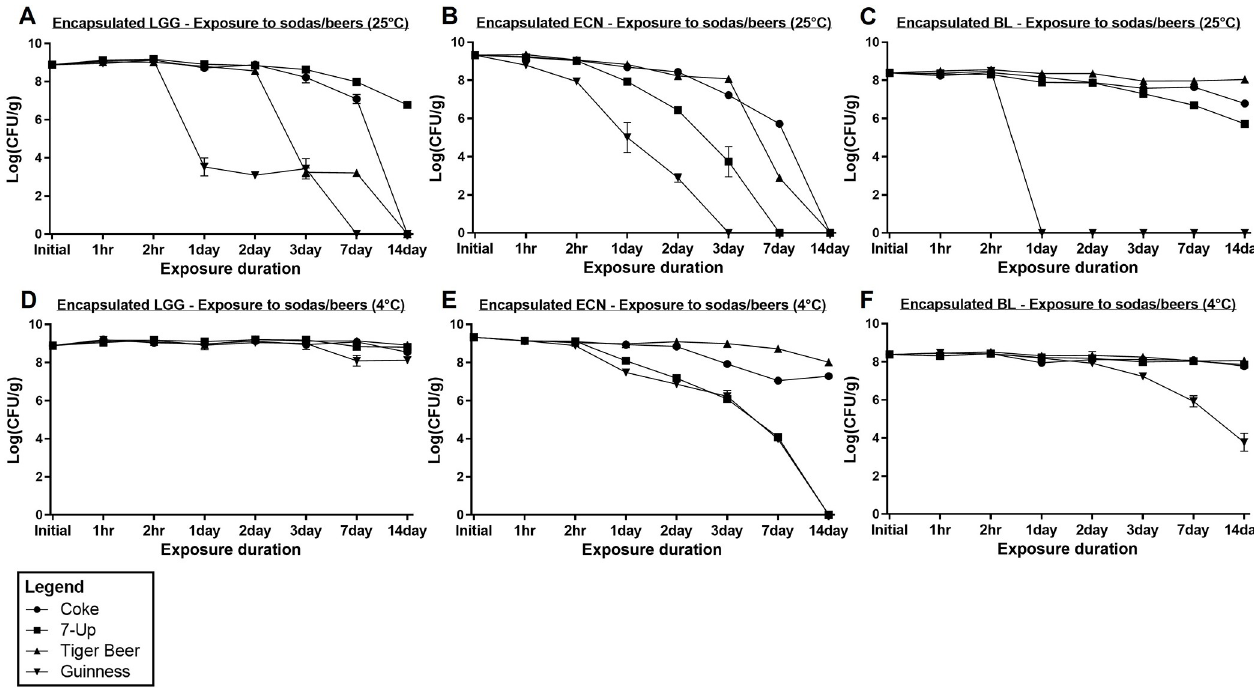
Fig 4. Encapsulated probiotics logCFU survival in various beverages at room temperature and refrigerated conditions for up to 14 days. (a) Encapsulated LGG survival at 25˚C, (b) encapsulated ECN survival at 25˚C, (c) encapsulated BL survival at 25˚C, (d) encapsulated LGG survival at 4˚C, (e) encapsulated ECN survival at 4˚C, and (f) encapsulated BL survival at